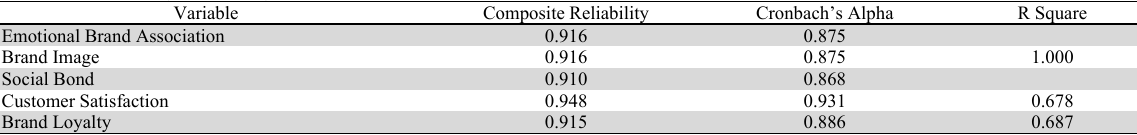
Internal consistency reliability